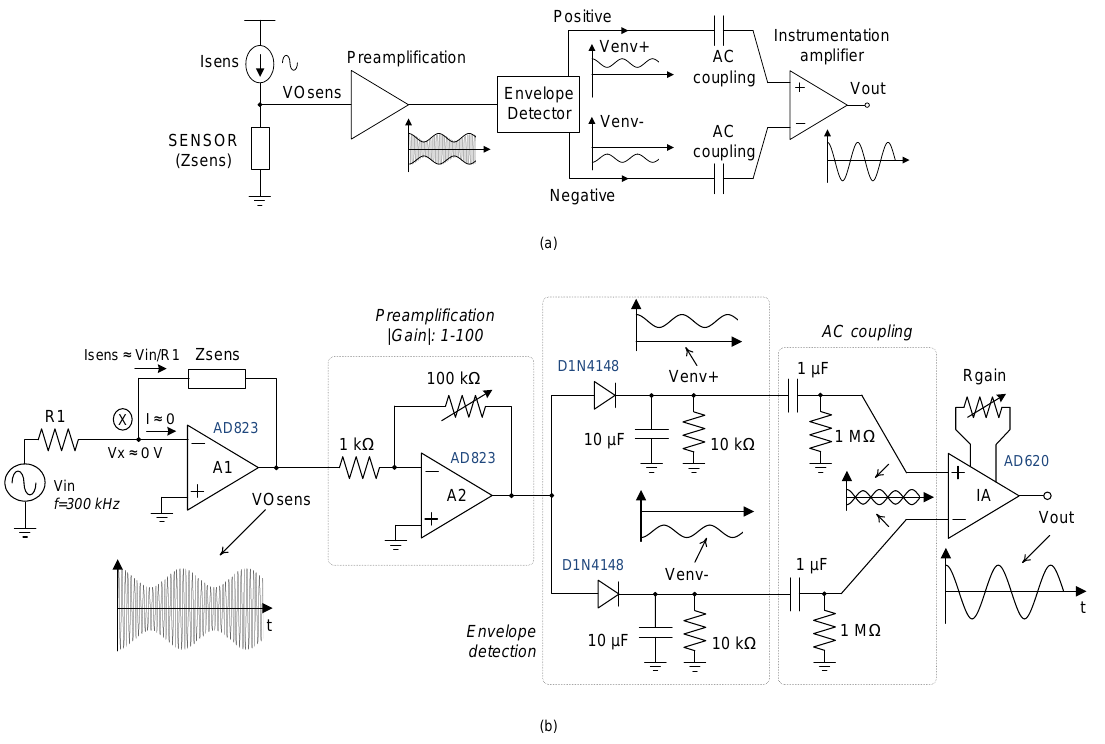
Figure 5 . Analog interface for the vibration sensor: ( a ) block diagram and ( b ) circuit implementation.